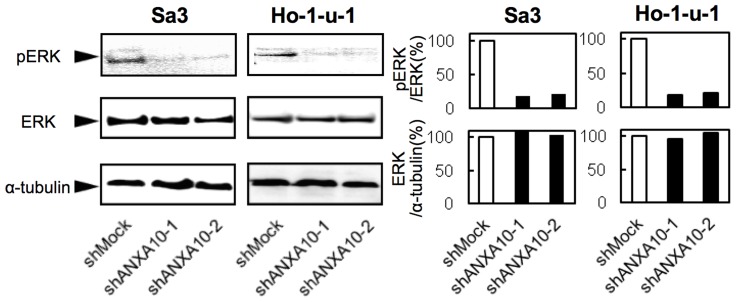
ANXA10 knockdown inhibits ERK activation.ANXA10 knockdown causes decreased levels of phosphorylated ERK (pERK) compared with the shMock-transfected cells (Sa3- and Ho-1-u-1-derived transfectants; 2 clones each); the ERK level is unchanged. Densitometric pERK/ERK protein data are normalized to α-tubulin protein levels.